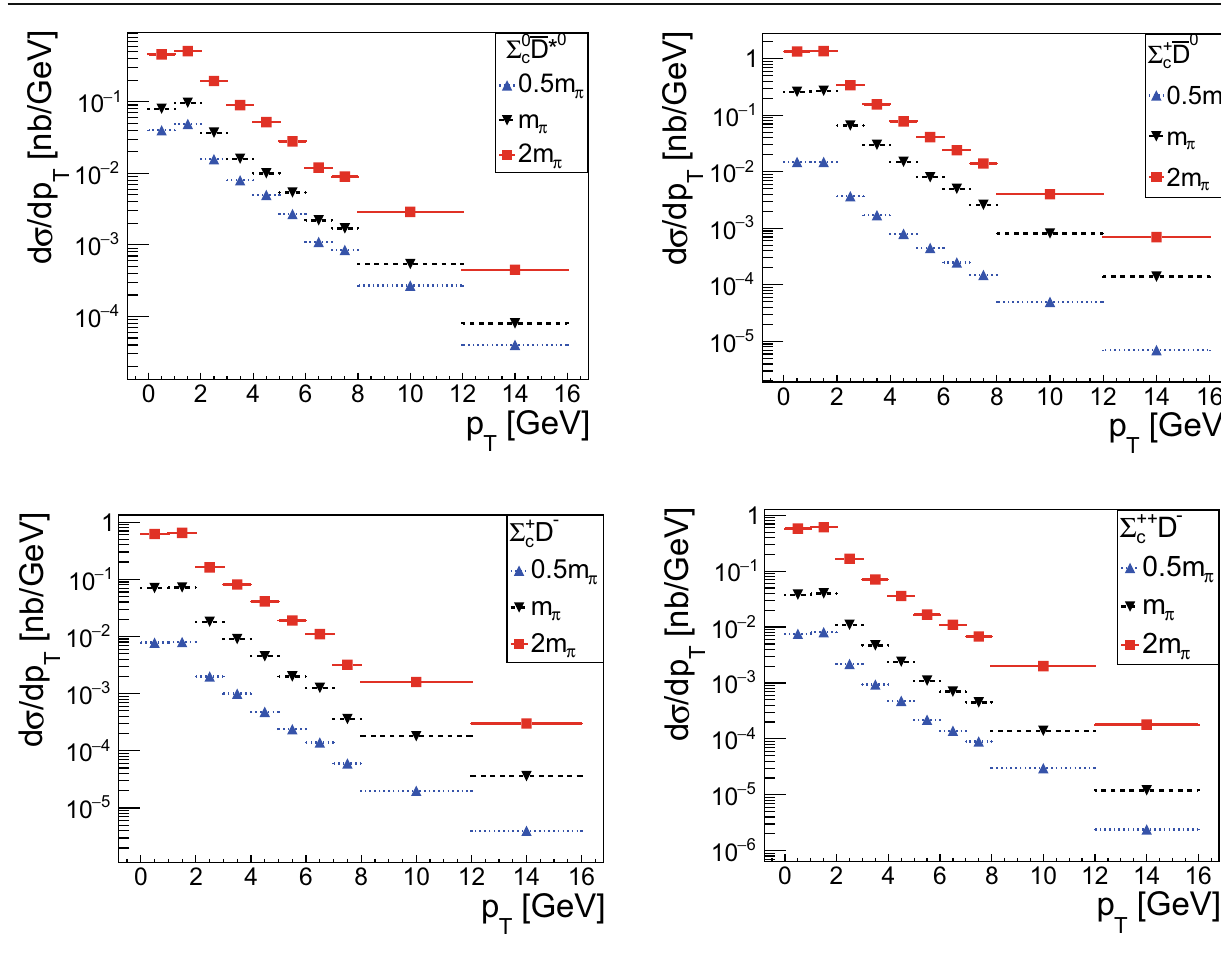
Fig. 6 The cross section of the inclusive production of the (cid:2) c ¯ D pairs in the figures, there are significant isospin deviation for the inclusive √ s = 7 TeV. The black in pp collisions at center-of-mass energy productions of the (cid:2) c ¯ D pairs. In our calculation, we use m π to inverted triangle, blue triangle, red box points are for the relative three momentum smaller than 0 . 5 m π , m π and 2 m π , respectively. As shown